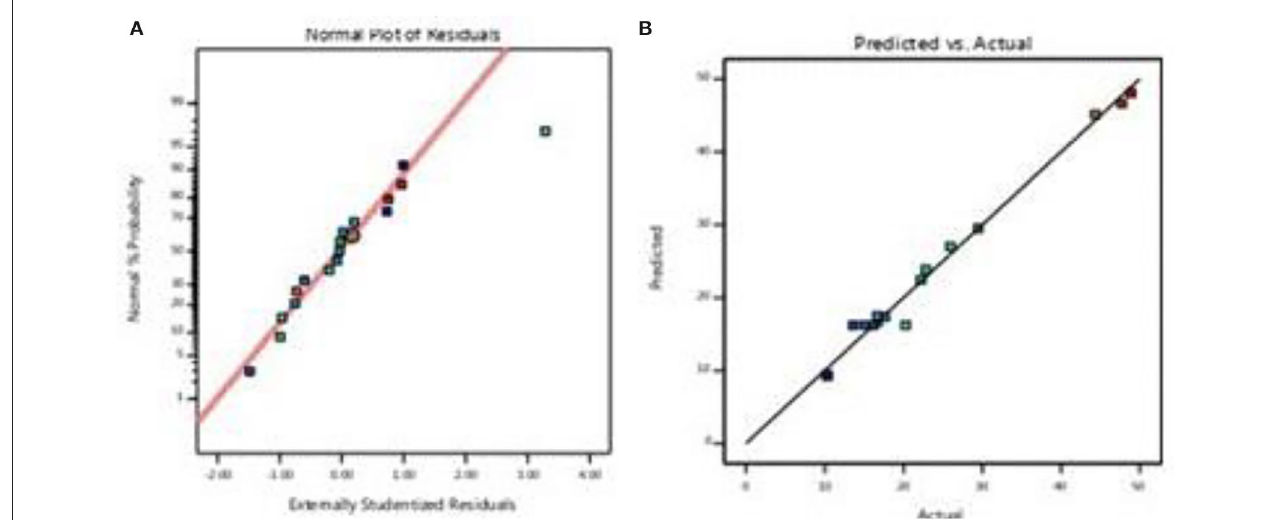
FIGURE 3 | (A) Normal probability and (B) predicted vs. actual values.